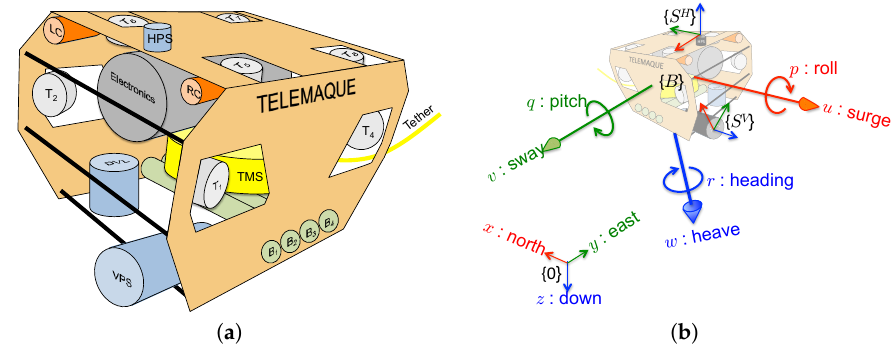
Figure 2. ( a ) Model of the underwater robot Telemaque, equipped for karstic exploration, and ( b ) frames